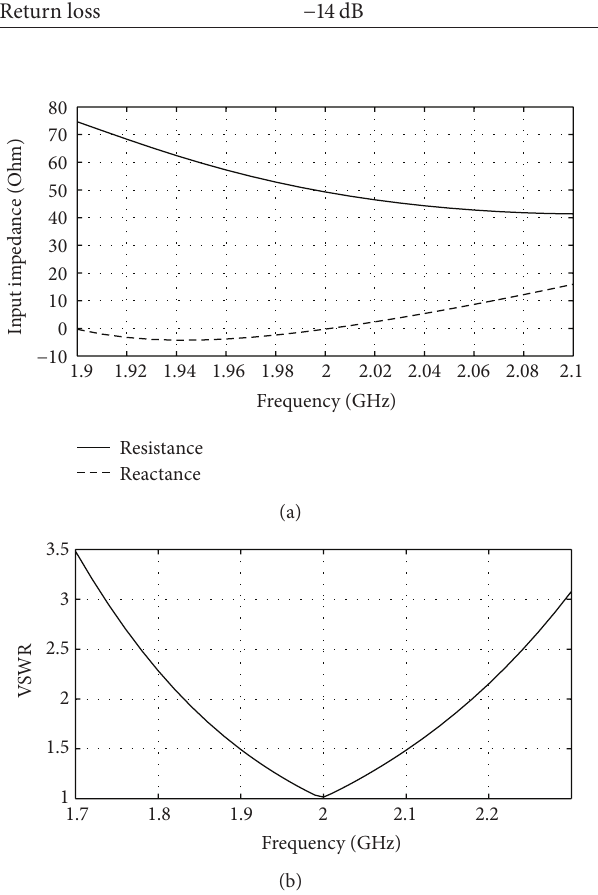
= 3.5 mm, 𝐷 = 2.3 mm, 1 in 2 in = 6.34 cm, 𝐿 = 3.82 cm, 1 in 2 in = 9.525 cm, 𝑊 = 𝐵 𝐵